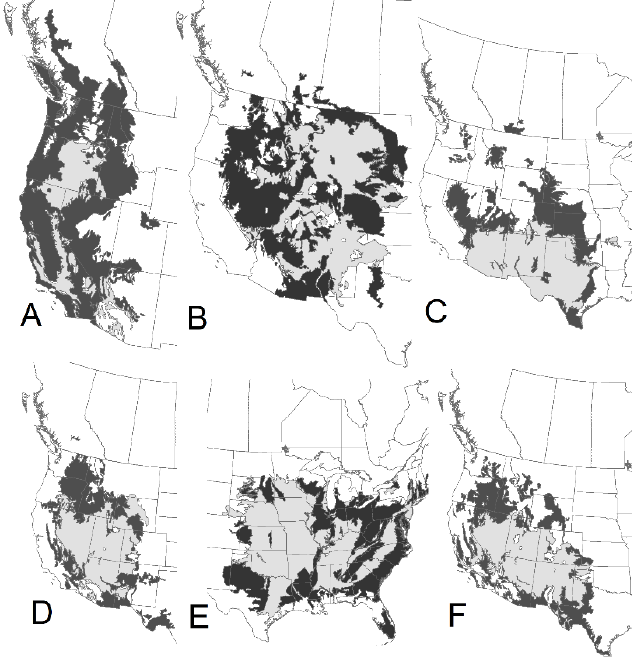
Figure 3. Potential for continued expansion (potential under near present climate in black) compared to current ranges (shaded gray) for combined western juniper and California juniper ( A ), Rocky Mountain juniper ( B ), southern western Juniperus ( C ), Utah juniper ( D ), eastern redcedar ( E ), and combined two-needle and singleleaf pinyon pines ( F ).